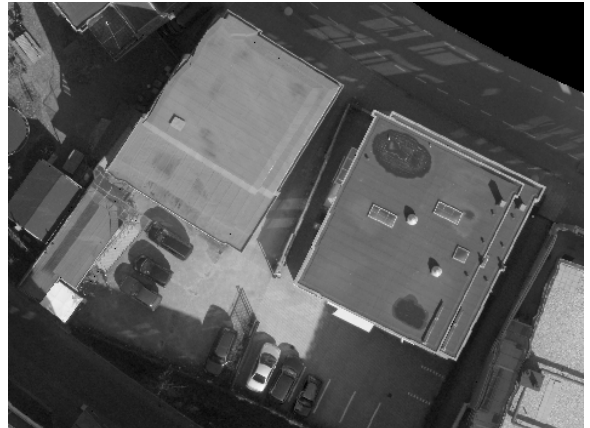
Figure 7: True ortho (detail) 2011; note the double roof edge at the building to the right, due to occlusion.